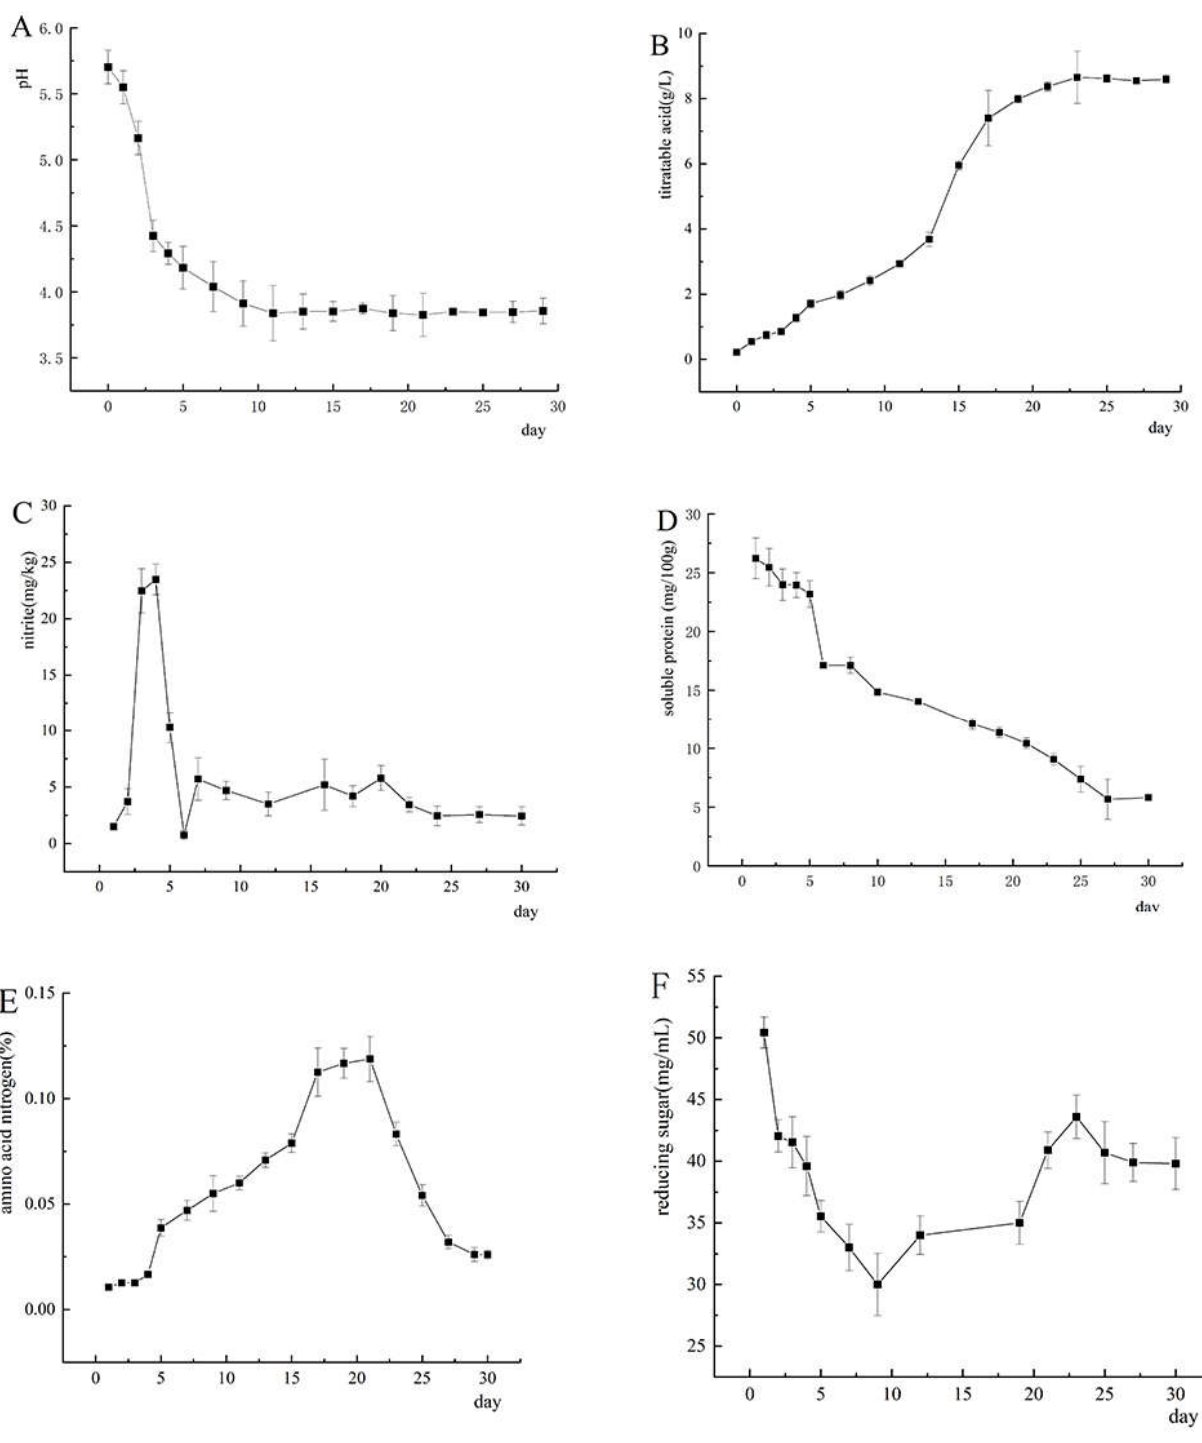
Figure 1. The variation trend of pH ( A ), the titratable acid ( B ), nitrite ( C ), soluble protein ( D ), amino acid nitrogen ( E ), and reducing sugar ( F ) during paocai